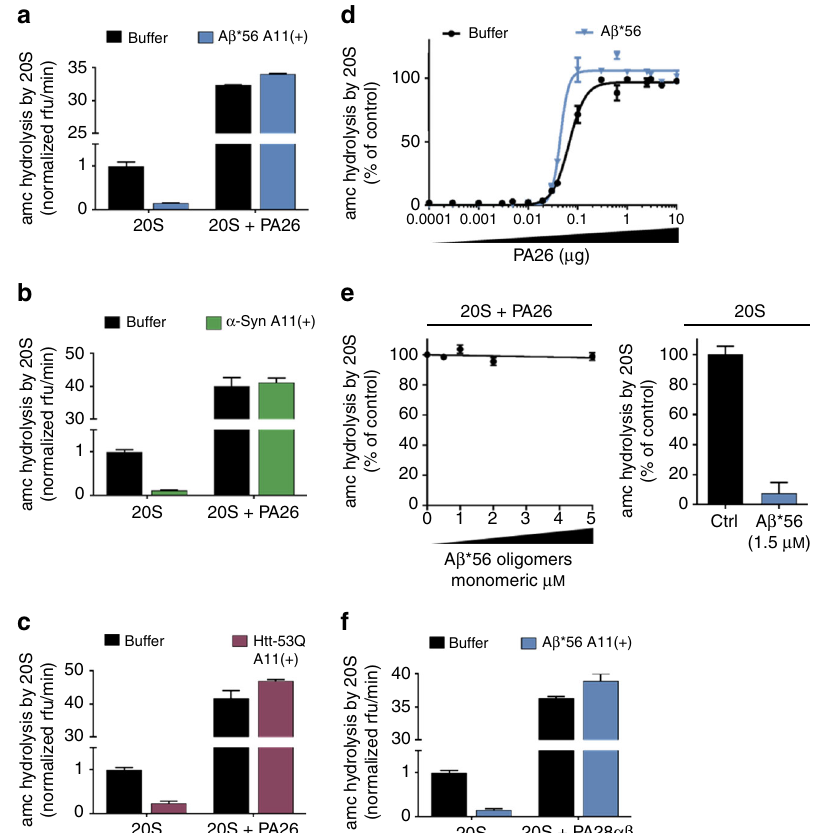
Fig. 4 A11( + ) oligomers cannot inhibit PA26 or PA28 αβ induced gate opening. a – c 20S Proteasome activity with and without the proteasome activator PA26 (1 μ g/100 μ l) was determined in the presence of A11( + ) oligomers from A β *56 (1.5 μ M, a ), α -Syn (0.1 μ M, b ), or Htt-53Q (0.1 μ M, c ). Broken graphs are used to show the extent of 20S inhibition, while still showing the extent of PA26 activation. d Proteasome activity in the presence of increasing concentrations of PA26 with and without A11( + ) A β *56 (1.5 μ M). The sigmoidal equation was fi t to the averages from three independent experiments (normalized to % activity) performed in triplicate, error bars ± SEM. For a – d , the 20S proteasome activity (nLPnLD-amc hydrolysis, rfu/min) was normalized to 20S control activity without activator. e Proteasome activity with PA26 activator (1 μ g/100 μ l) in the presence of increasing concentrations of A β *56 (left). Activity of 20S proteasome (without PA26) with 1.5 μ M A β *56 is shown at right. f Same experiment as in a , with human PA28 αβ replacing PA26. The concentrations of oligomers are calculated based on the respective monomeric peptide/protein mass. All controls contained an equal volume of buffer identical to that of the respective aggregates. The data are representative of three or more independent experiments performed in triplicate. Error bars represent ± standard